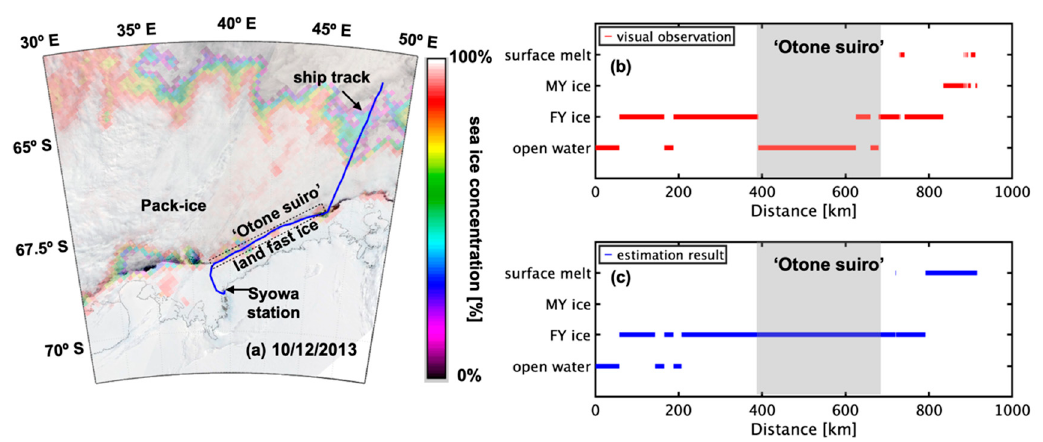
Figure 6. ( a ) Track of the Japanese ice breaker Shirase from 9 December 2013 to 4 January 2014. ( b,c ) Comparison of sea ice classification by ship-based visual observations and by this classification algorithm.